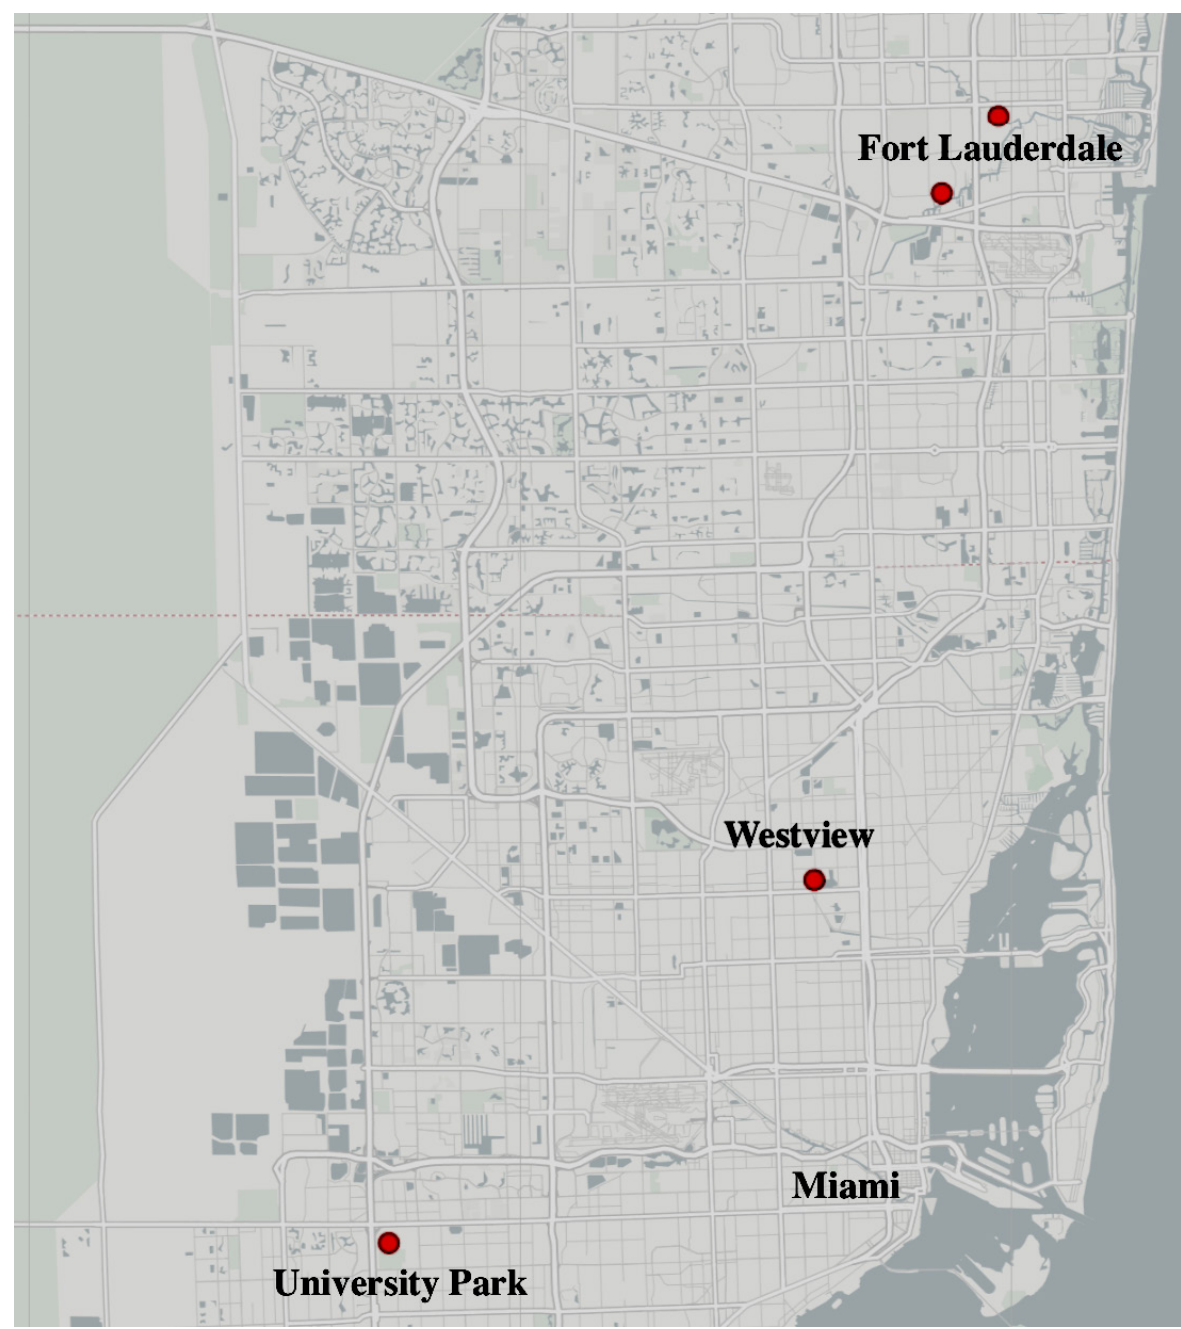
Fig 1 . Records of Syllophopsis sechellensis in Florida (map made using